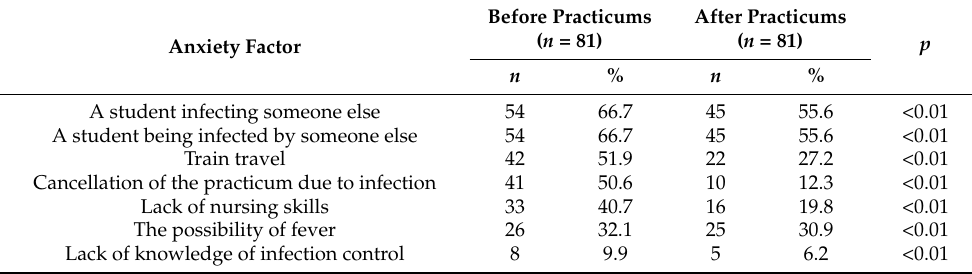
Table 4. Changes in anxiety factors before and after